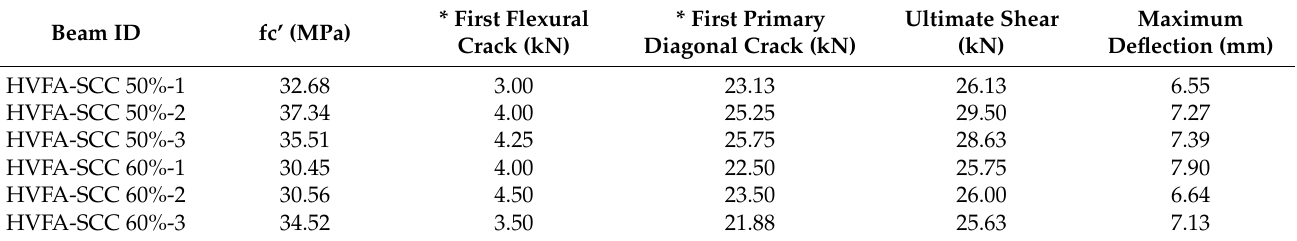
Table 5. Summary of experimental results of the HVFA-SCC